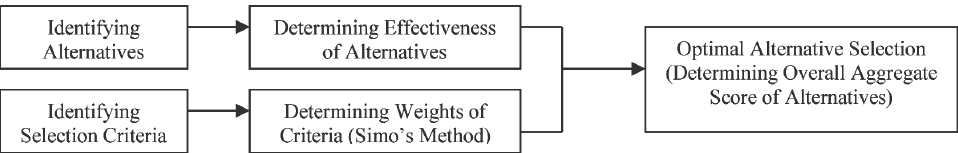
Fig. 2. Simple Multi-Attribute Rating Technique